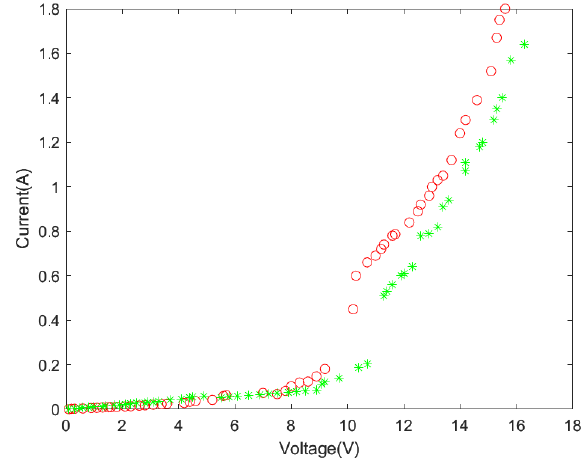
Figure A4. The I-V characteristic comparison between fabricated CNPs with steel (green) and graphite (red) electrodes which indicate the same behavior.